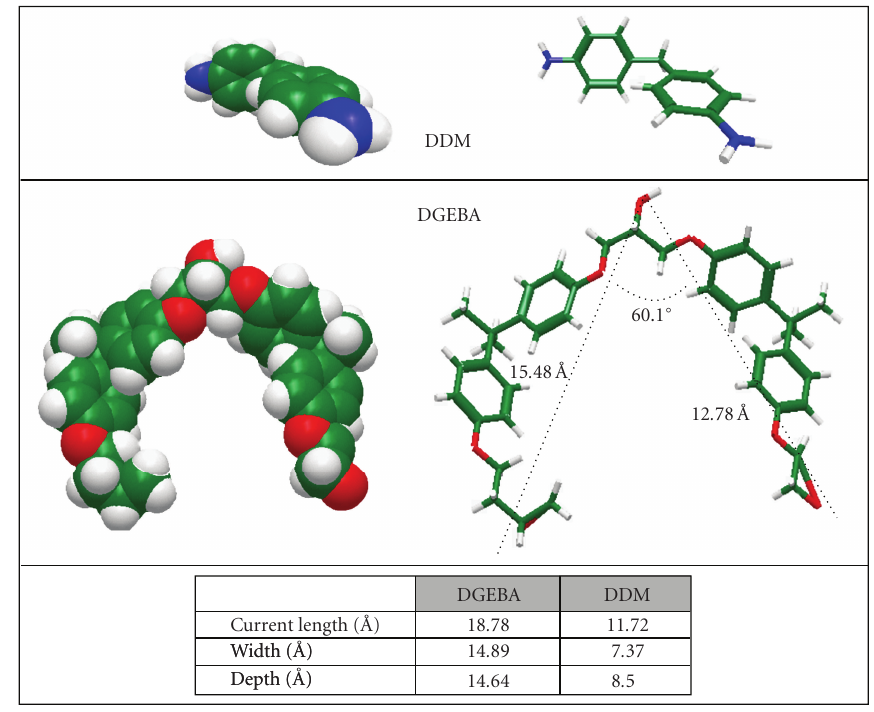
Figure 6: The most stable configurations of DGEBA and DDM.